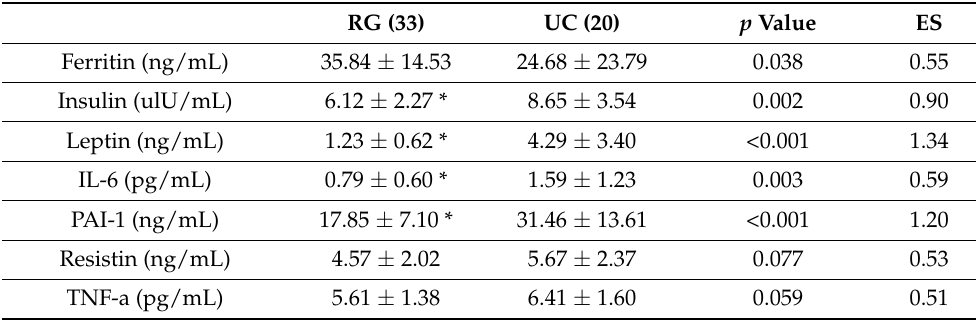
Table 2. The blood biomarkers data in the RGs and UCs female